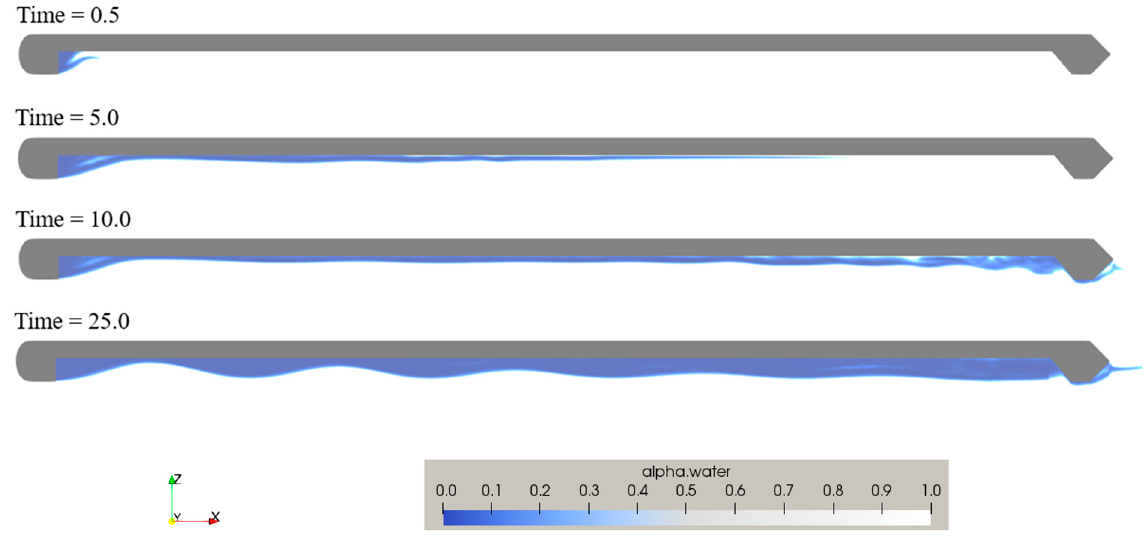
Figure 10. Side view of the evolution of the air layer’s behavior over time ( F r = 0.173, C q = 0.149). The air circulation zone causes low pressure outside the air layer, as shown in Figure 11. The repeated high and low pressures outside the air layer caused an undulation of the air layer, which generated an air layer wave. The generated air layer wave is observed in Figure 11. The air layer wave was related to the velocity of the injected air, and can be expressed with the equation below [26].